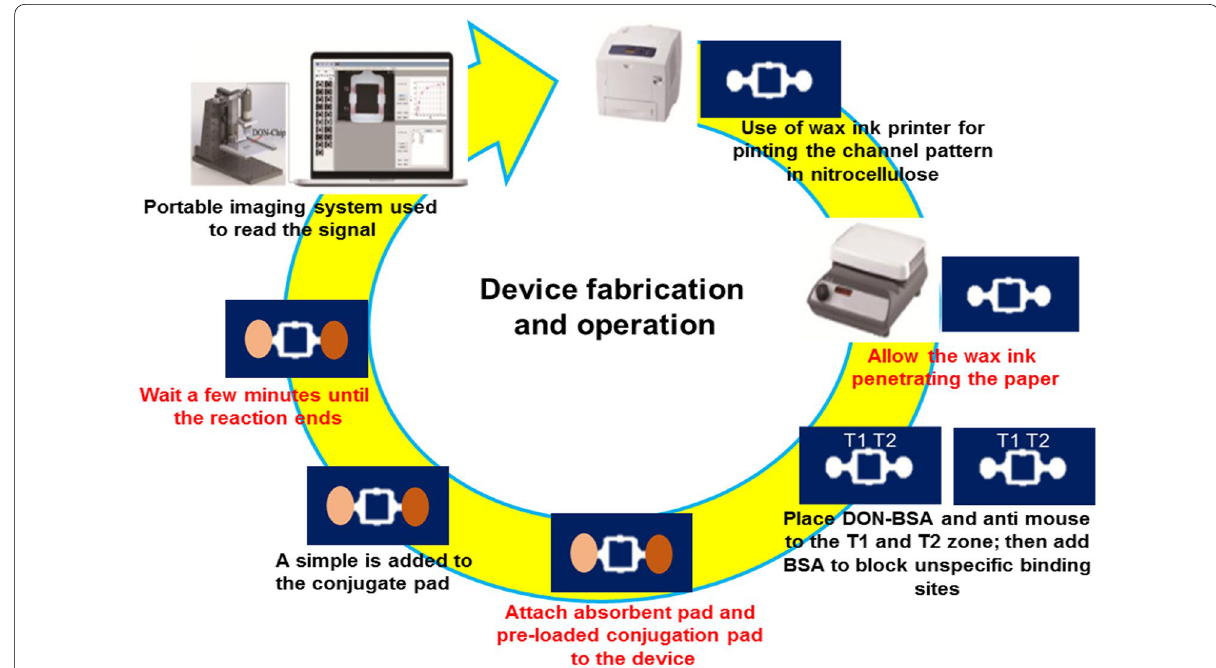
Fig. 2 Schematic illustration of DON-Chip production and operation